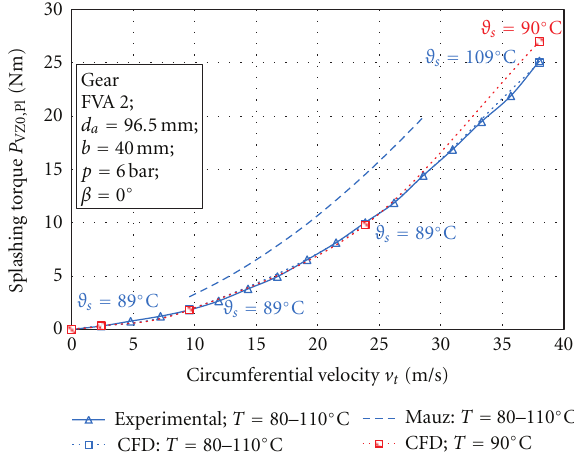
Figure 10: Results in terms of resistant torque versus circumferen- tial velocity—e ff ect of the temperature.